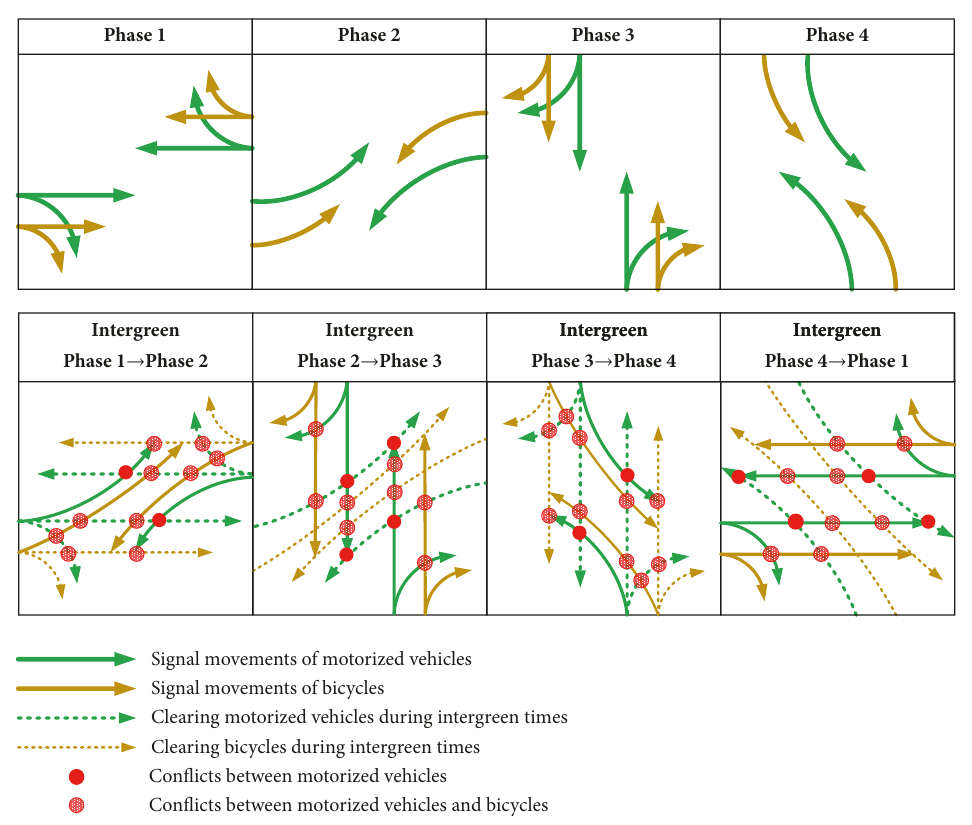
Figure 1: A typical stage-based signal phasing plan and its resulting traffic conflicts at signalized intersections in China.